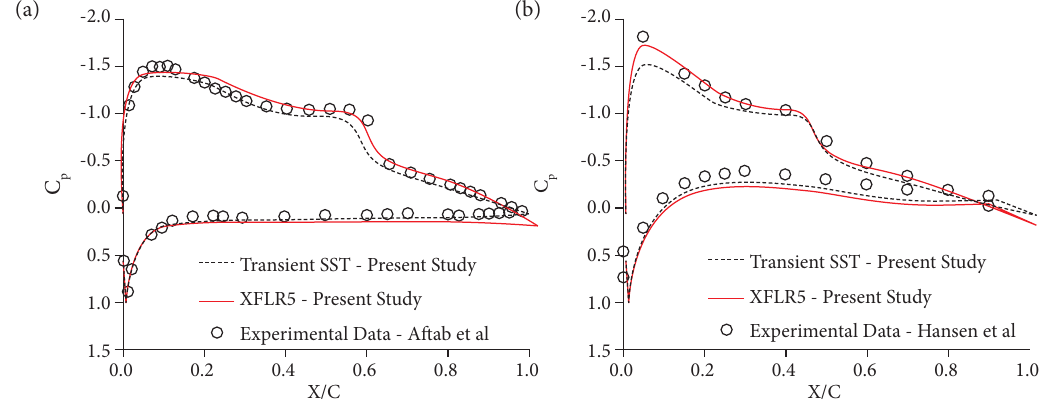
Figure 5. Grid convergence for CFD results: pressure coefficients. (a) NACA 4415 at 6 o AoA; (b) NACA 0021 at 5 o AoA.